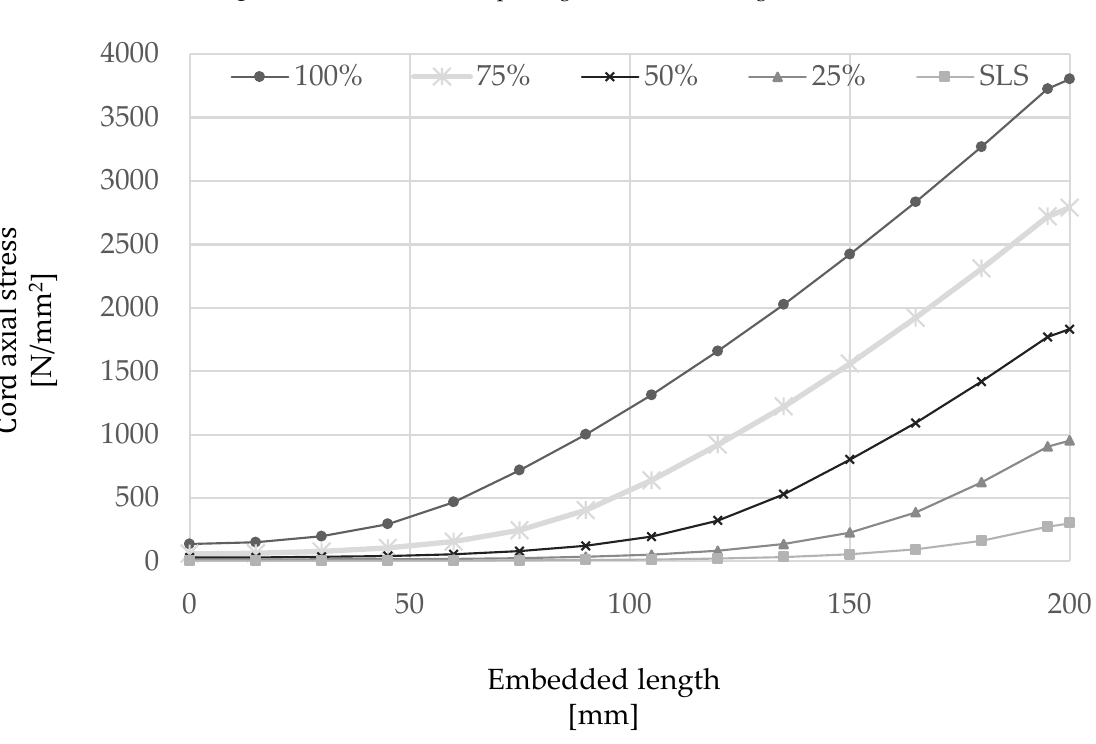
Figure 15. Distribution of cord axial stress along the embedded length of 200 mm at several load levels.